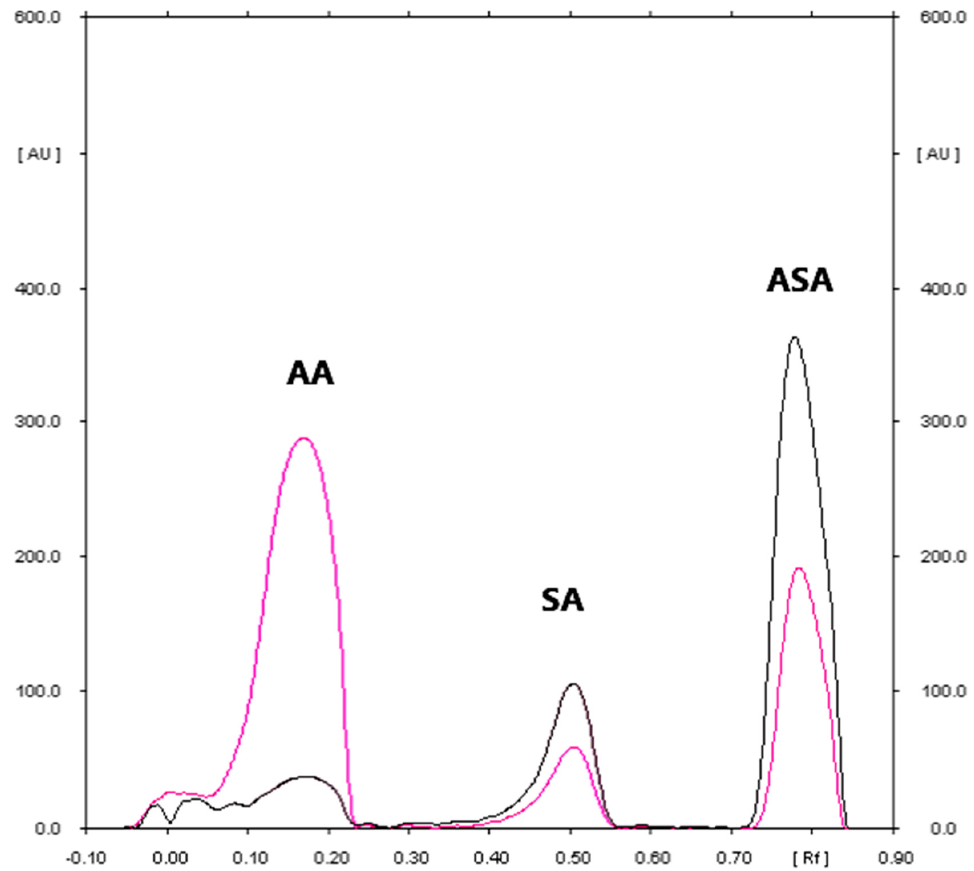
Figure 2. The densitogram of ascorbic acid (AA), salicylic acid (SA), and acetylsalicylic acid standard (ASA) coming from commercial effervescent tablets sample (Densitometric scanning were performed at absorption maximum equal to 200 nm and 268 nm for ASA (black line) and AA (pink line)).